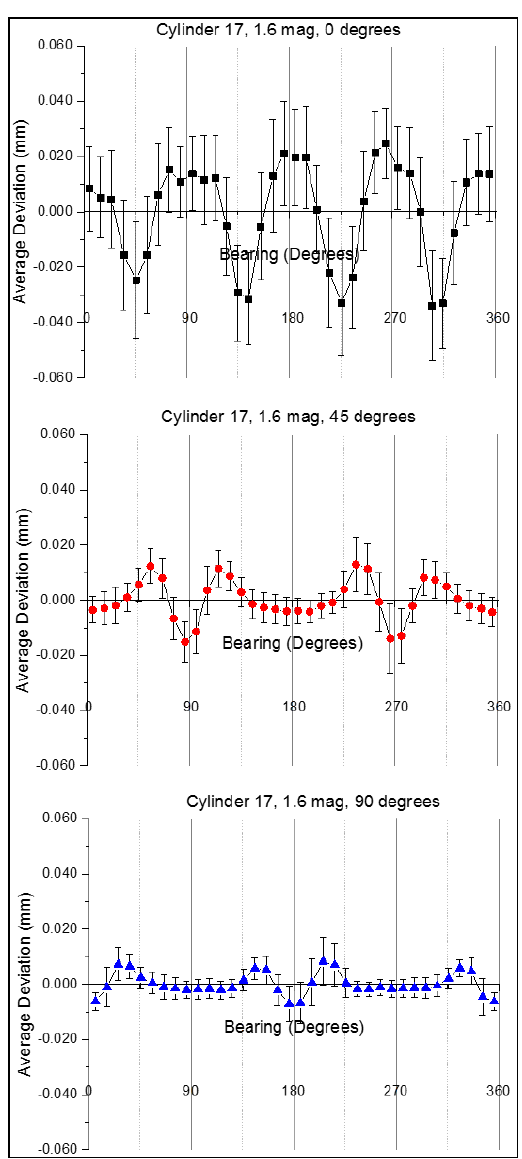
Figure 17: Average deviation, taken every 10 ⁰ , of fit point of cylinder 17 to surface. Error bars are equal to the standard